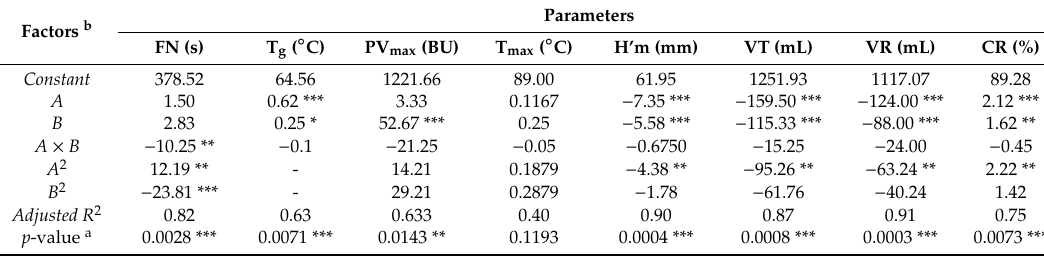
Table 3. E ff ects of independent variables, expressed as their corresponding coe ffi cients on the predictive models for dough rheological properties during fermentation, gelatinization properties and α -amylase activity of KCl-NaCl